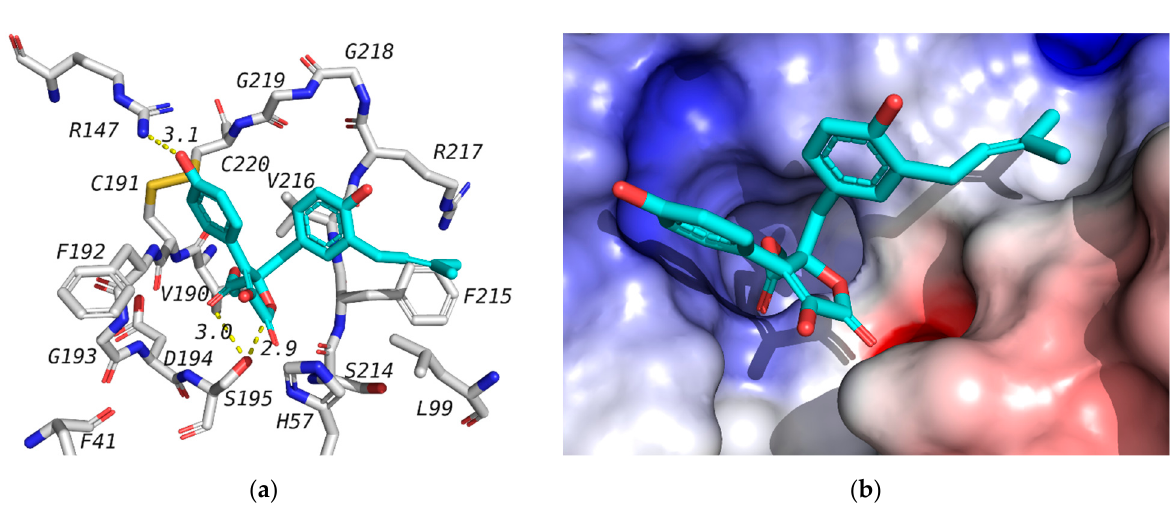
Figure 3. Docking of compound butyrolactone I ( 1 ) (blue) in the active site of human NE. ( a ) Interactions of 1 with amino acids in the active site. ( b ) Docking pose of 1 .